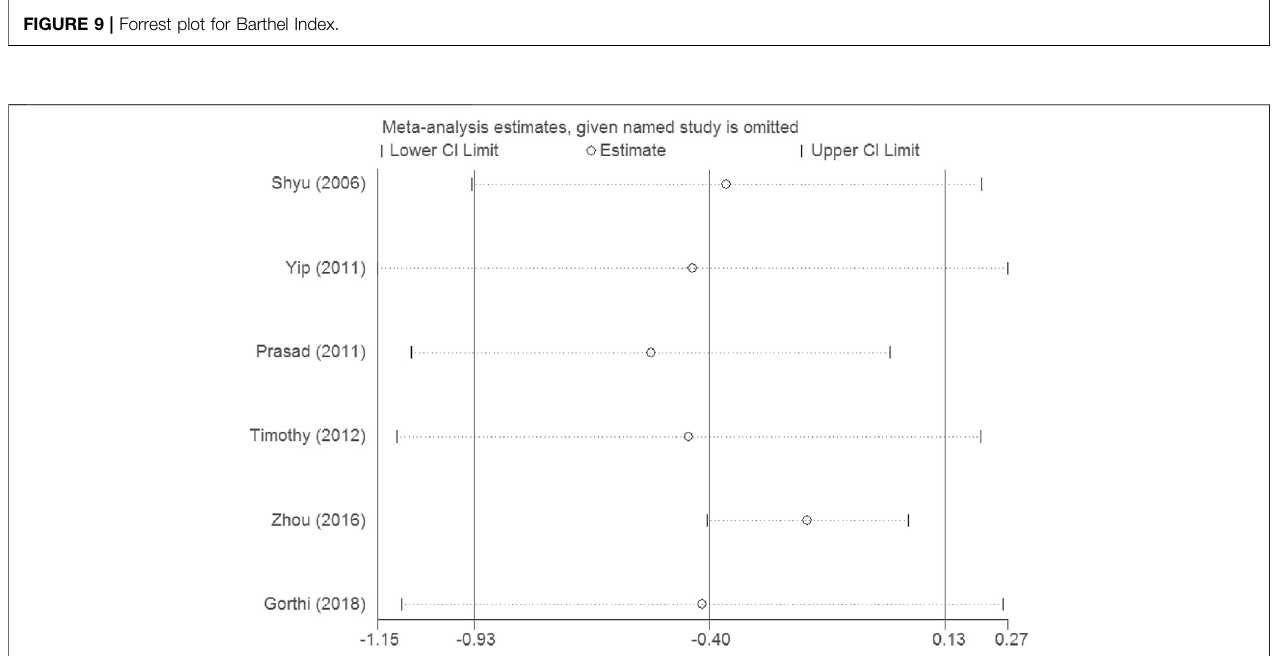
FIGURE 10 | Sensitivity analysis for NIHSS. CI, con fi dence interval.